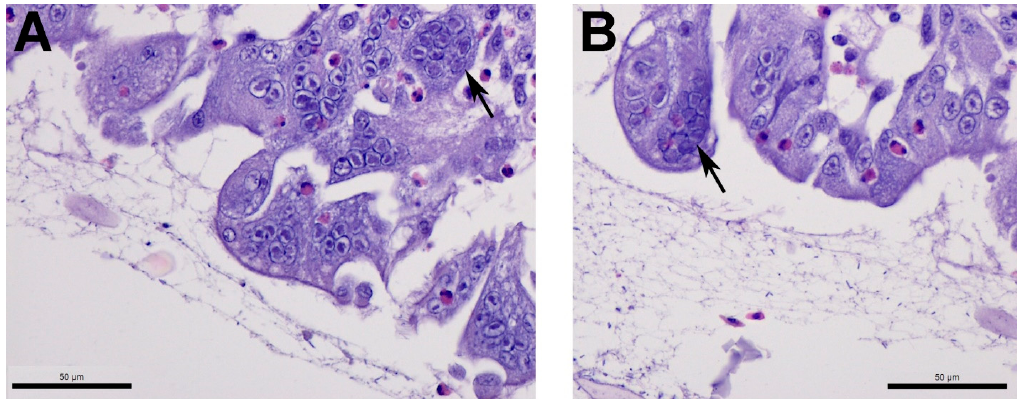
Figure 5. Tracheal microscopic lesions consistent with infectious laryngotracheitis infection at 20 weeks-of-age. ( A ) Numerous syncytia with intranuclear inclusions (arrow). ( B ) Another trachea from the same group demonstrating syncytia with intranuclear inclusions (arrow). No ciliostasis was observed in the tracheas of birds from any of the groups.